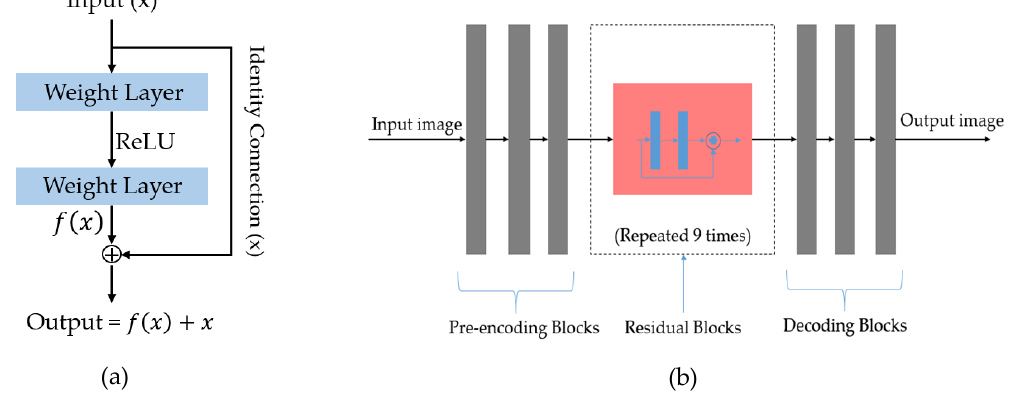
Figure 5. Illustration of the generator network used in our study: ( a ) residual block architecture that is used to increase depth of network; ( b ) draw sketch structure of generator network.